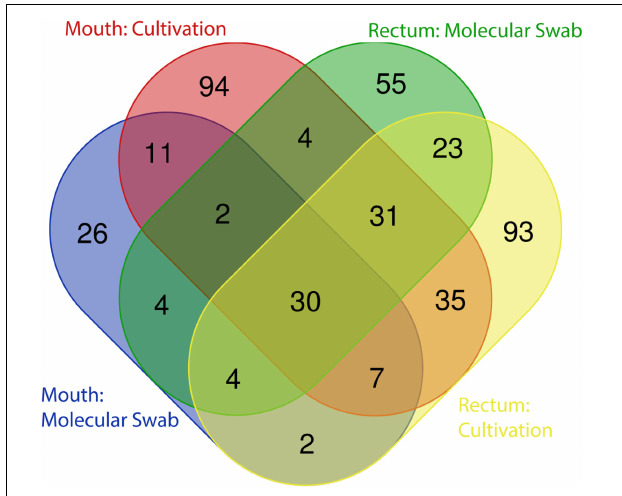
FIGURE 2 | Distribution of ASVs between cultivation and molecular controls. The majority of ASVs detected in the original inocula were shared between the mouth and rectum, while approximately half of all ASVs detected through cultivation were not detected in the directly sequenced samples.